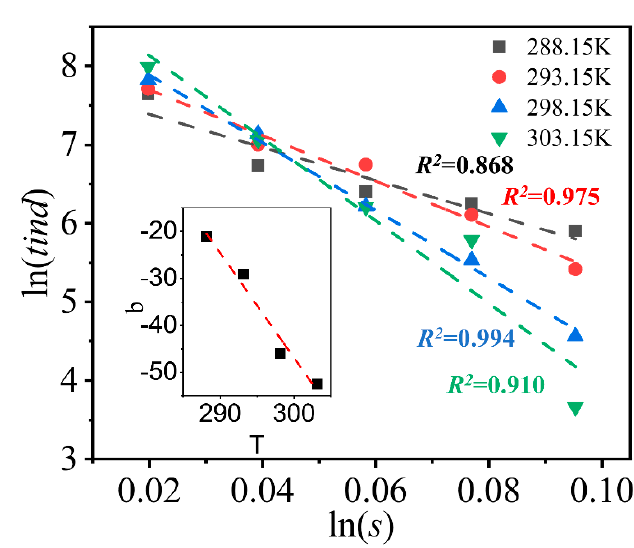
Figure 12. The relationship between supersaturation and induction time. The dotted lines denote the linear fitting lines of the ln( t ind ) and ln( s ), and the R 2 values in black, red, blue, and green represent the R 2 values of the linear fits of data obtained at 288.15 K, 293.15 K, 298.15 K, and 303.15 K, respectively. The inset in the figure describes the linear relation of the slopes of fitting lines and